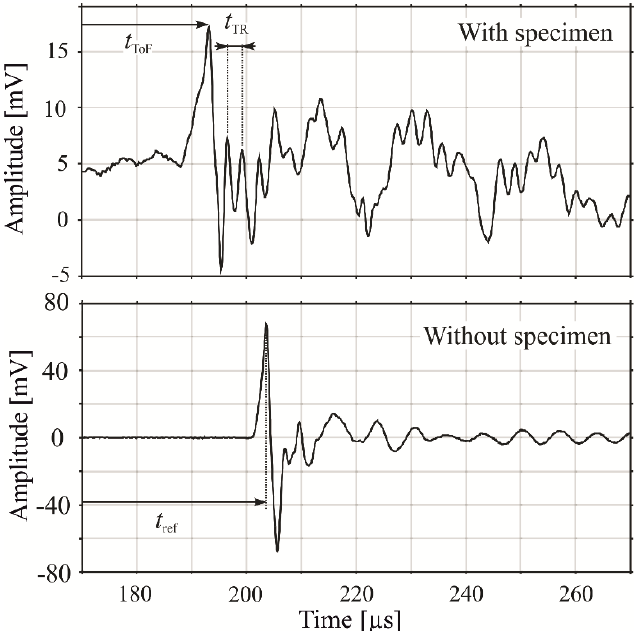
Figure 2. Representative signals for the proposed technique. The upper and lower graphs show a measured signal with and without a specimen, respectively. The times t TR and t ToF are independent parameters, which enable the discrimination between the influence of the plate thickness and the material properties. An initial measurement of the time of flight between the transducers ( t ref ) enables the determination of absolute values for both parameters simultaneously. The observable signal oscillations after the pulse detection feature components other than only the in-plate reflections and are further analyzed in the signal measurement and processing section.